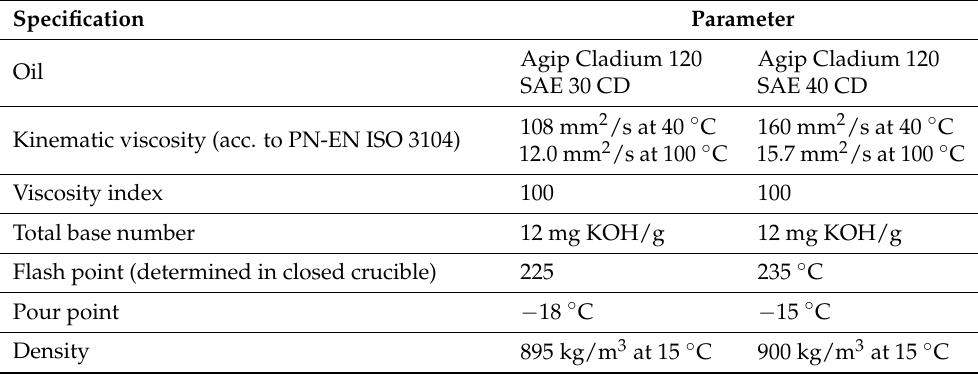
Table 4. Physical and chemical properties of the Agip Cladium 120 CD lubricating oils used in the tests declared by the manufacturer